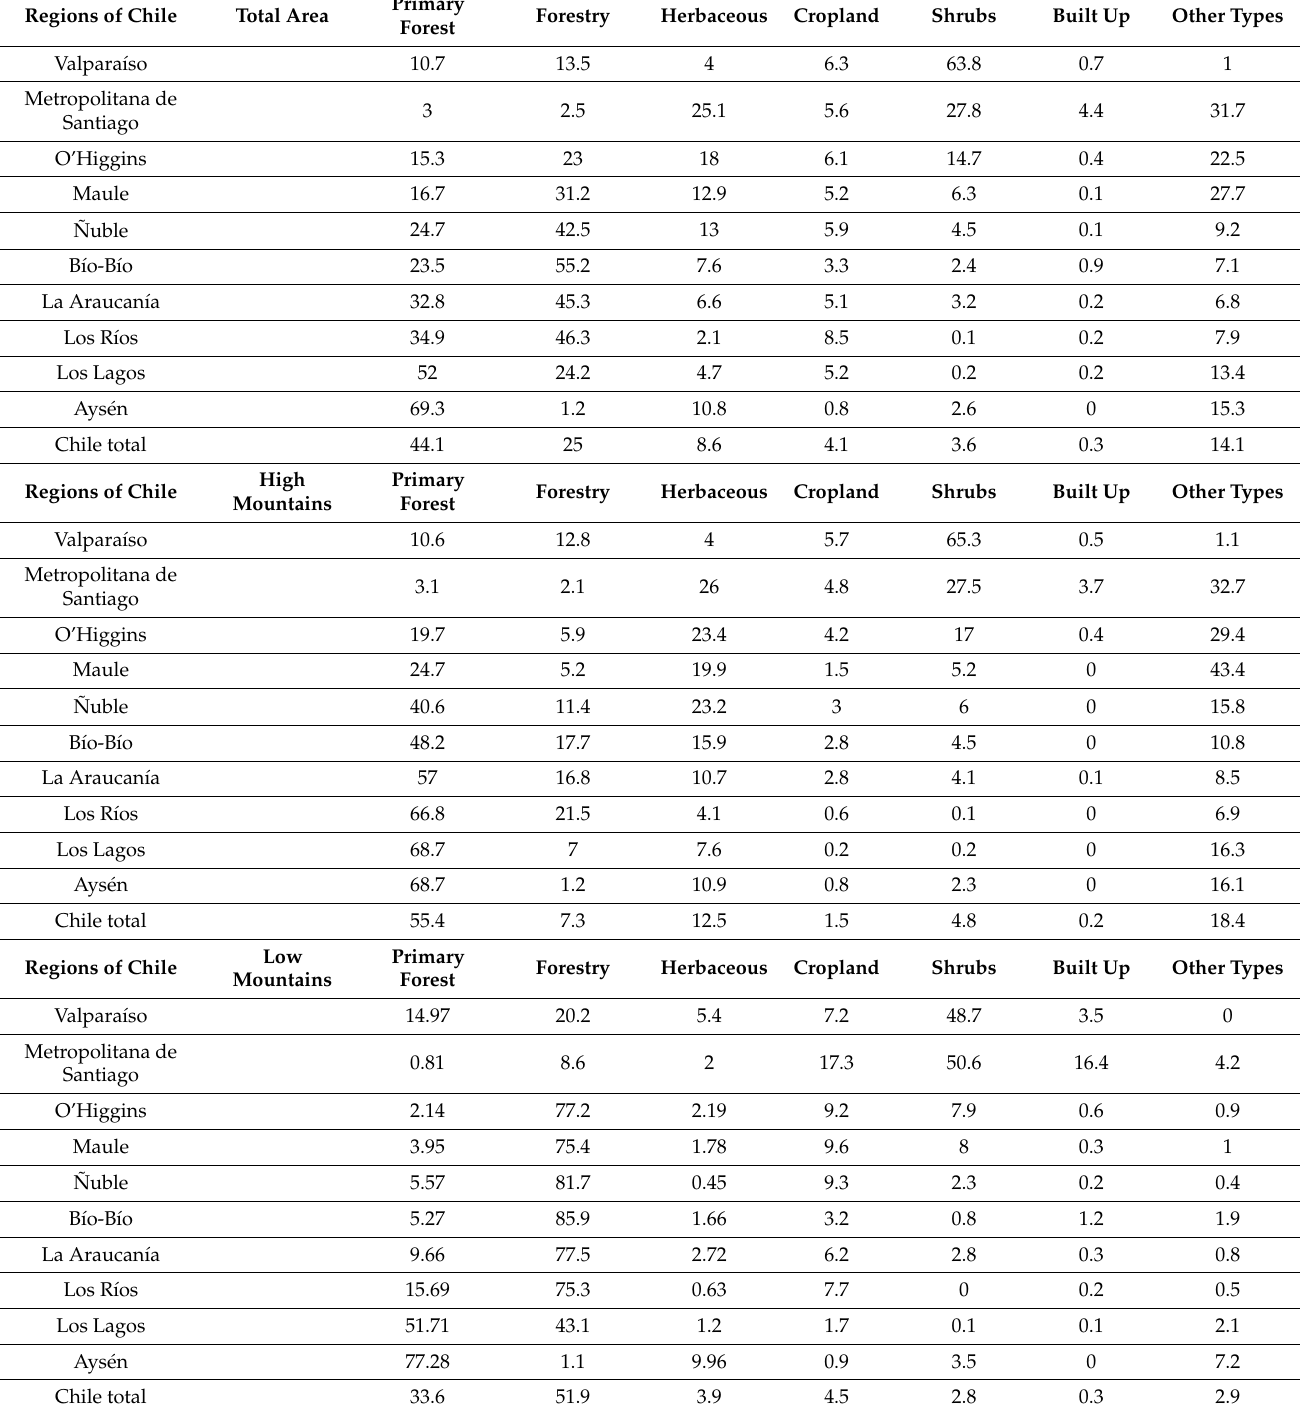
Table 2. Land use distribution in the biome studied considering the whole overlapping area and focusing on high and low mountain areas in relative shares (in percentage) Source: Own